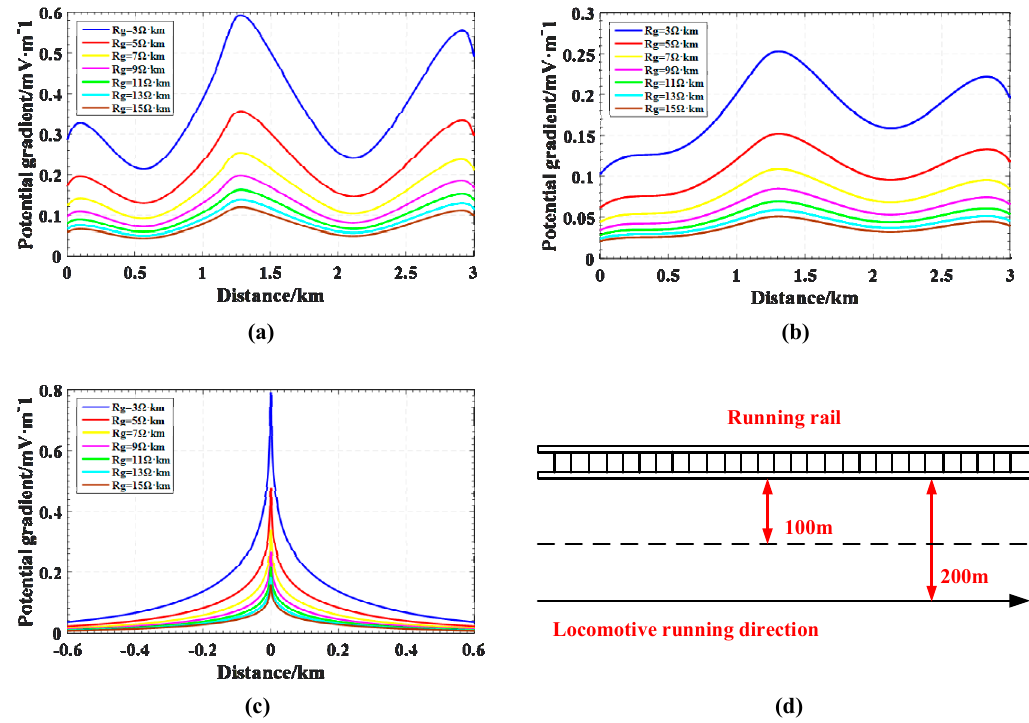
Figure 9. Effect of transition resistance on the surface potential gradient: ( a ) Along the locomotive running direction (100 m); ( b ) Along the locomotive running direction (200 m); ( c ) Vertical to the locomotive running direction (600 m); ( d ) Position instructions.